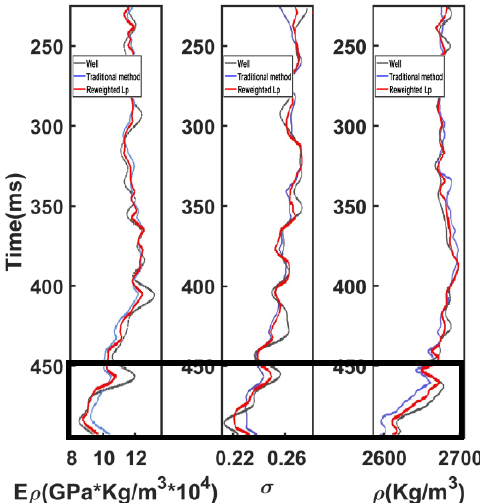
Figure 31. Inversion results of the trace near the well and the logged well.